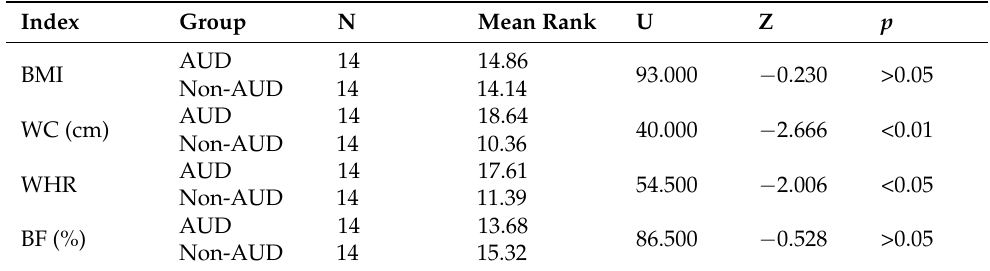
Table 2. Anthropometric and body composition characteristics of AUD versus non-AUD